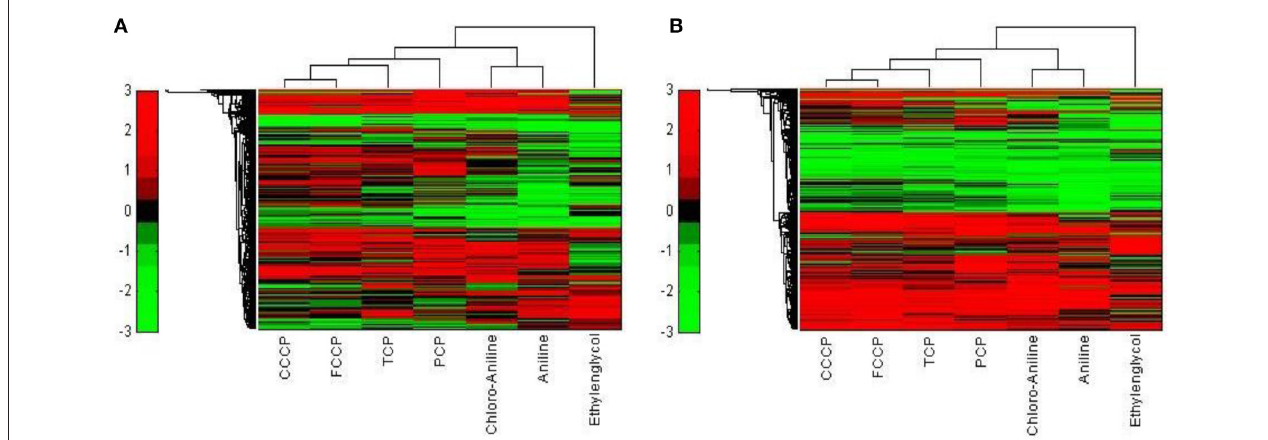
FIGURE 7 | Hierarchical cluster analysis of C3A cells exposed to seven compounds (Ethylenglycol, Cl-aniline, Aniline, PCP, CCCP, FCCP, and TCP). (A) The hierarchical cluster analysis is based on the 5000 most varying genes. (B) The hierarchical cluster analysis is based on the significantly regulated genes (|M| > 2 and p adj < 0.1).